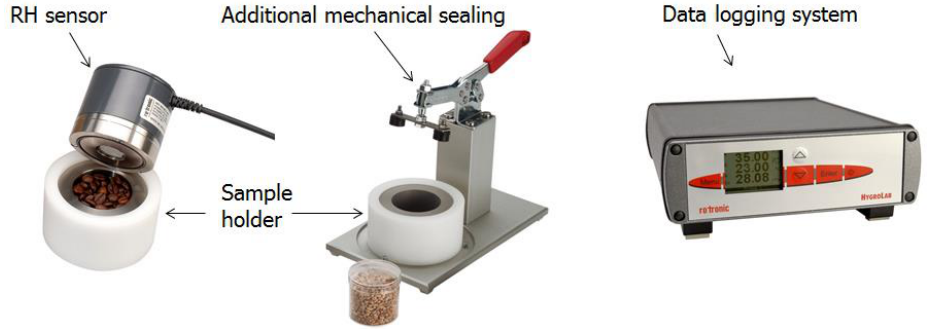
Figure 3. Set-up for the RH measurement.